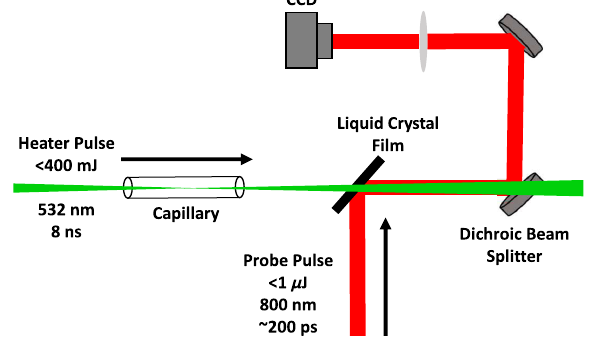
FIG. 1. A schematic of the survivability experimental setup, including the heater, capillary, and probe laser is